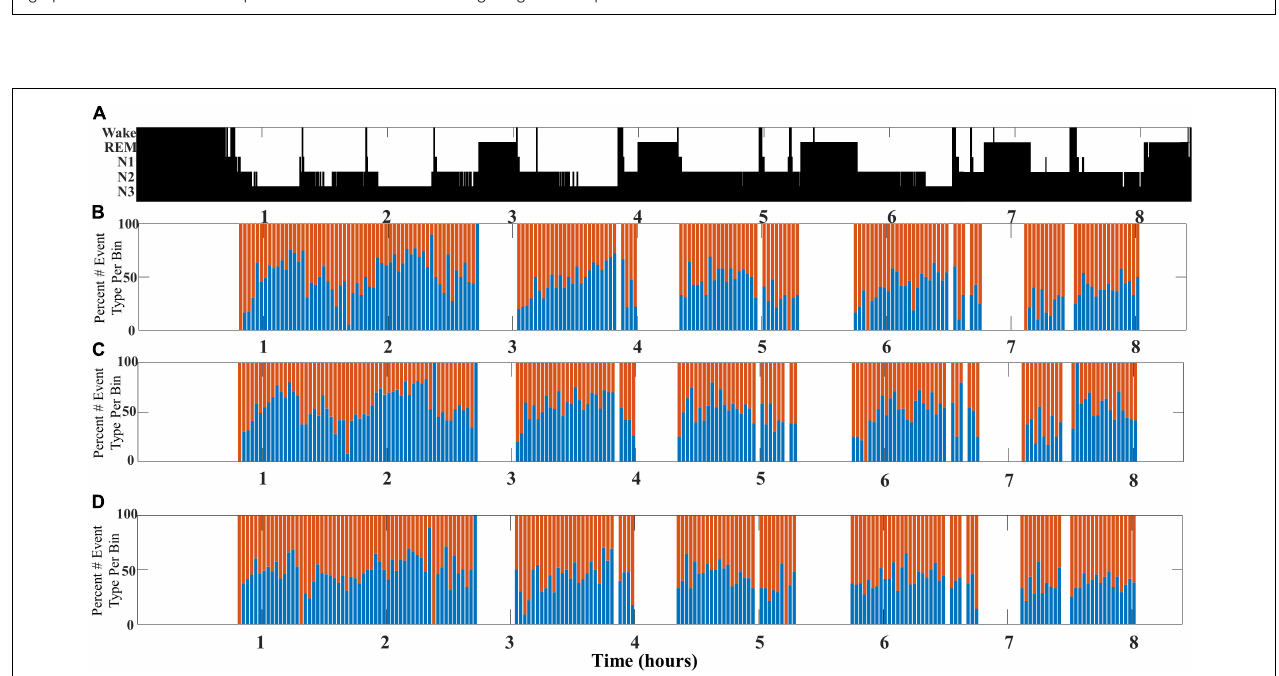
FIGURE 4 | An illustrative example comparing SWA composition as measured from different channel pairs for a single participant (DREAMS Subject 3). (A) A hypnogram marking sleep stages for a single participant’s overnight sleep recording is illustrated. (B) The percentage of early-fast spindle/slow waves (red bars) detected in channel CZ and late-fast spindle/slow waves (blue bars) detected in channel FP1 are graphed in time bins of 2 min. (C) The percentage of early-fast spindle/slow waves (red bars) detected in channel FP1 and late-fast spindle/slow waves (blue bars) detected in channel FP1 are graphed in time bins of 2 min. (D) The percentage of early-fast spindle/slow waves (red bars) detected in channel CZ and late-fast spindle/slow waves (blue bars) detected in channel CZ are graphed in time bins of 2 min.